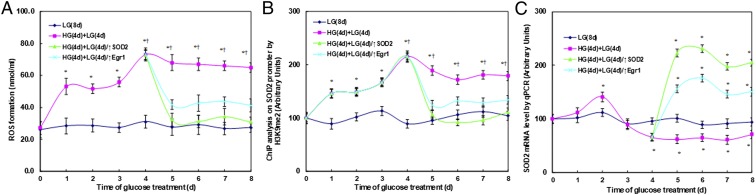
Hyperglycemia-induced persistent oxidative stress and SOD2 suppression were restored by expression of SOD2/Egr1 lentivirus. The human ACS-5003 neurons were treated by either 8-d LG [LG(8 d)] or 4-d HG plus 4-d LG [HG(4 d)+LG(4 d)] or the cells were infected on day 4 by SOD2 lentivirus [HG(4 d)+LG(4 d)/↑SOD2] or Egr1 lentivirus [HG(4 d)+LG(4 d)/↑Egr1]; the cells were then used for further analysis: (A) ROS formation (n = 4), (B) ChIP analysis on SOD2 promoter (n = 4), and (C) SOD2 mRNA levels [n = 4; *P < 0.05 vs. LG(8 d) at day 0 group; ¶P < 0.05 vs. LG(8 d) at day 1 group]. Data are expressed as mean ± SEM.